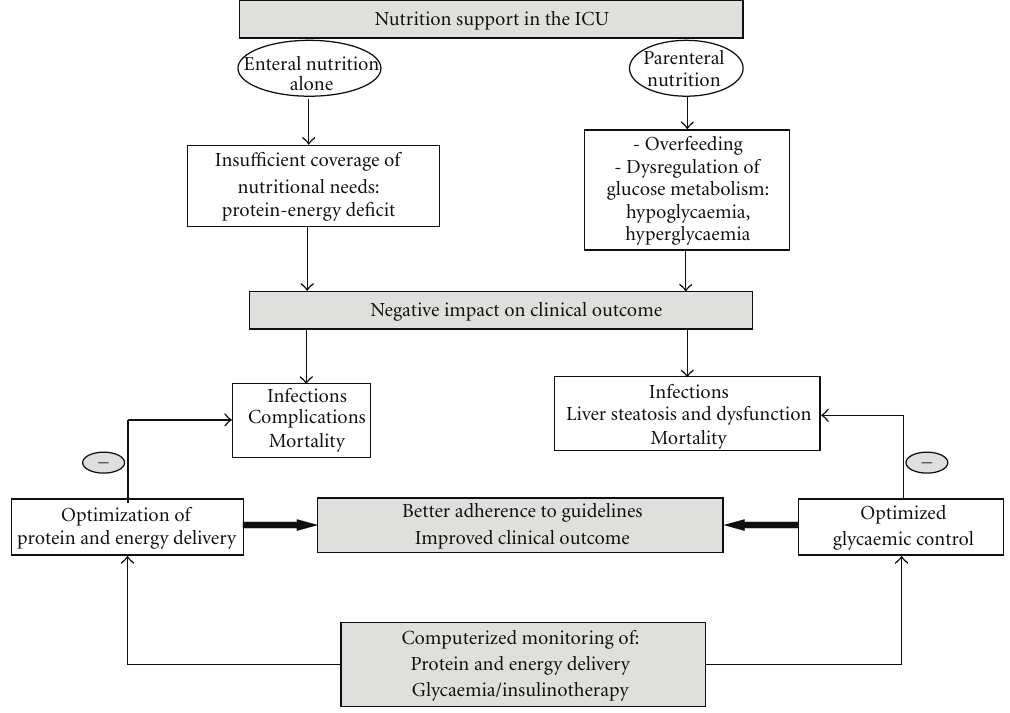
Figure 3: Conceptualization of the expected impact of the computerized monitoring of the nutritional and metabolical care in the intensive care unit (ICU). Although it is the recommended nutrition support, early enteral nutrition (EN) is associated with an insu ffi cient coverage of energy and protein needs, leading to a protein-energy deficit, itself associated with an increased risk of infections and complications and increased mortality. The use of parenteral nutrition (PN) could be associated with overfeeding, and especially hyperglycaemia, which is associated with an increased risk of infections and liver metabolic complications and increased mortality. By allowing an early and tight adaptation of protein and energy delivery to nutritional targets and an optimization of glycaemic control, the computerized monitoring of the nutritional and metabolical care could improve the adherence to clinical guidelines and the clinical outcome of ICU